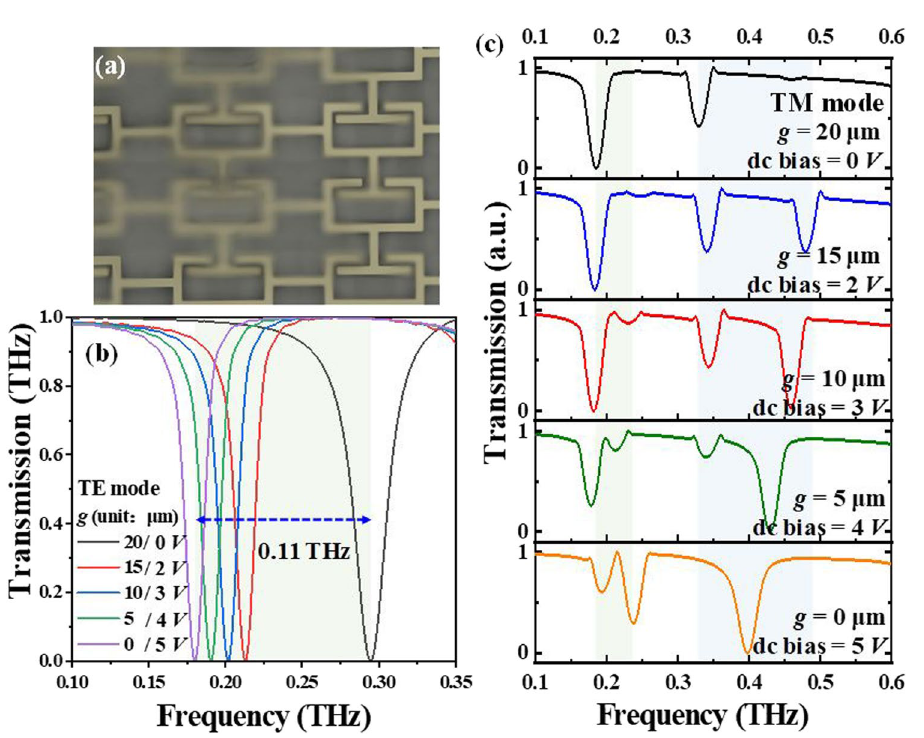
Figure 7. Experimental results of proposed CLM by changing different g value. ( a ) Optical microscopy image of released CLM. Transmission spectra of CLM with different g value at ( b ) TE mode and ( c ) TM